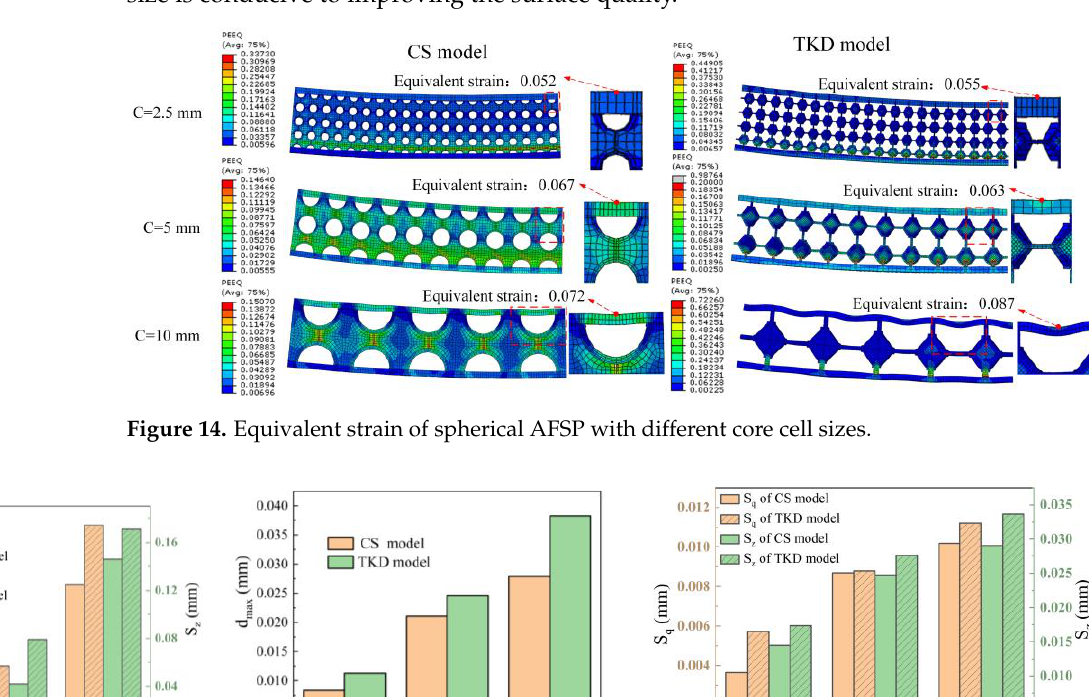
d of spherical max